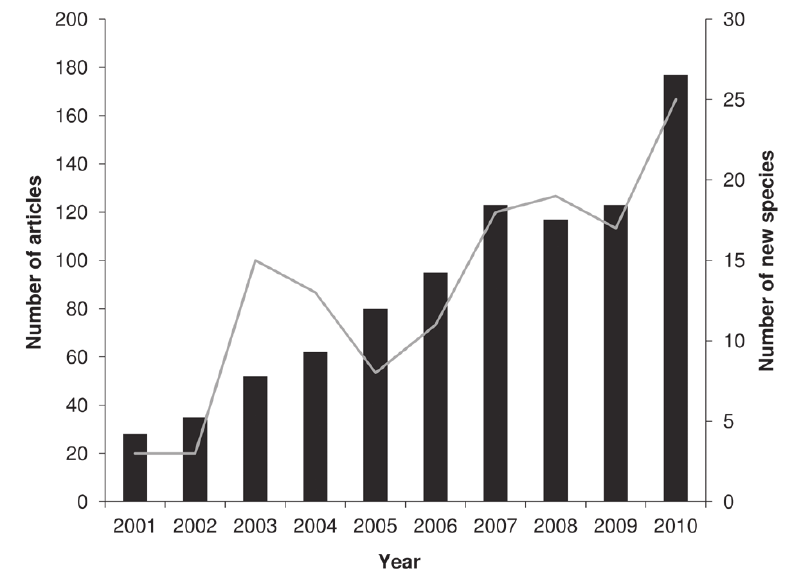
Figure 4 - Number of published articles on amphibians (bars) and number of new species discovered (line) between 2001 and 2010 in Brazil.